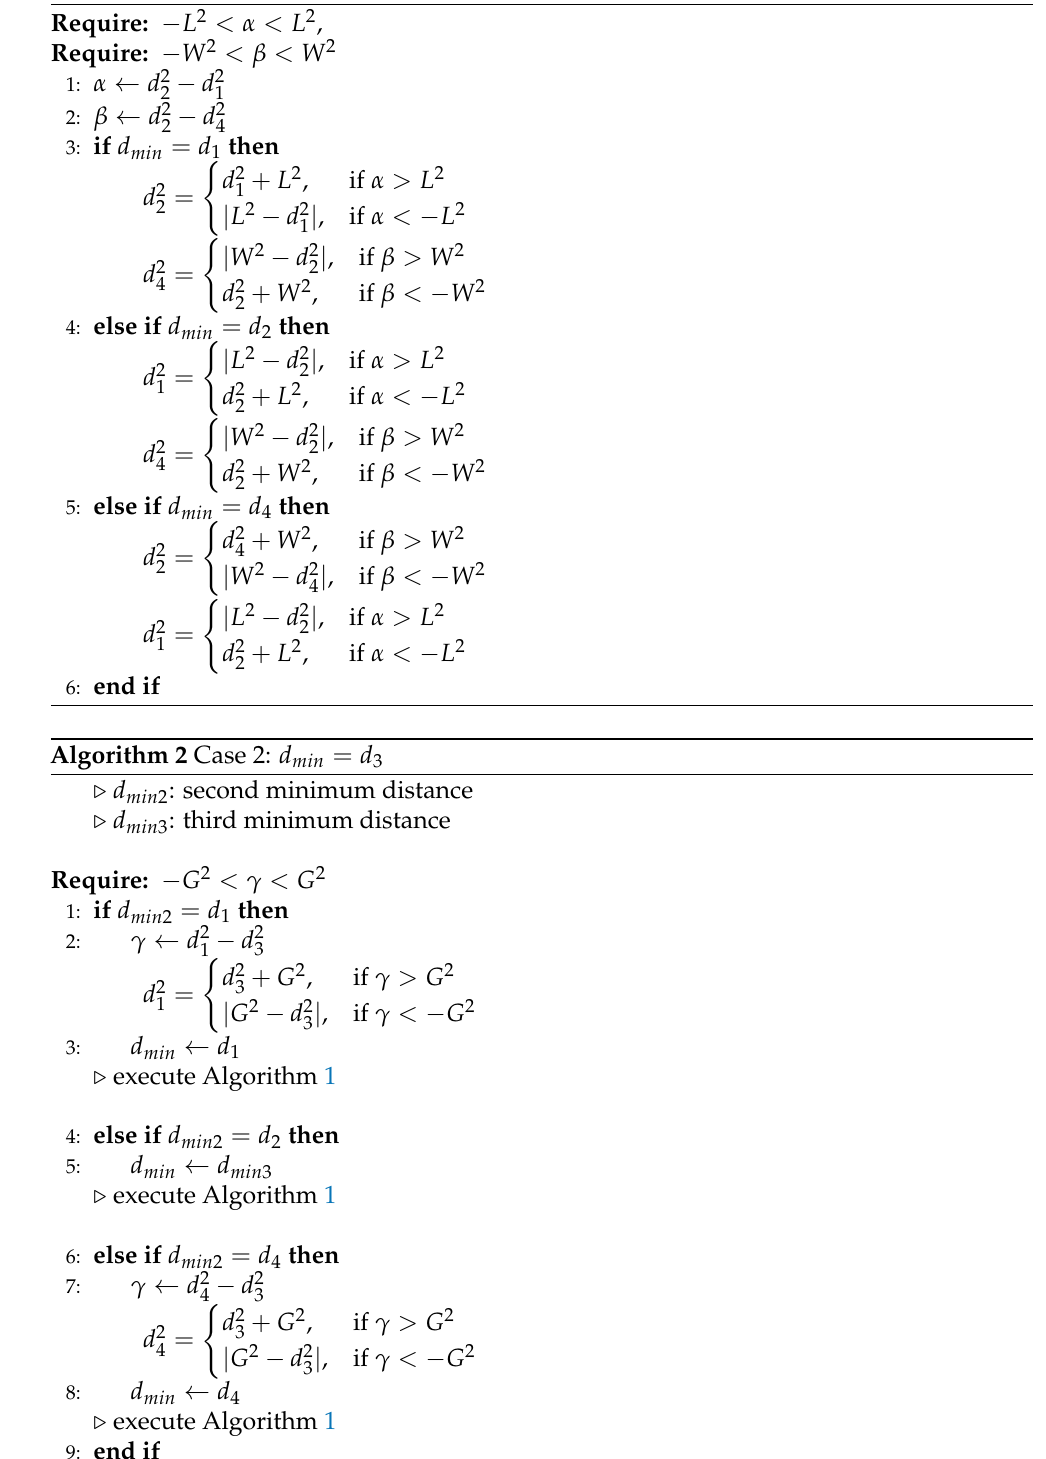
Algorithm 1 Case 1: d min (cid:54) = d 3